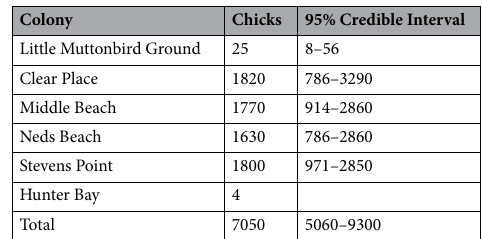
Table 2. Estimated number of chicks from each colony on Lord Howe Island, 2014–2015.